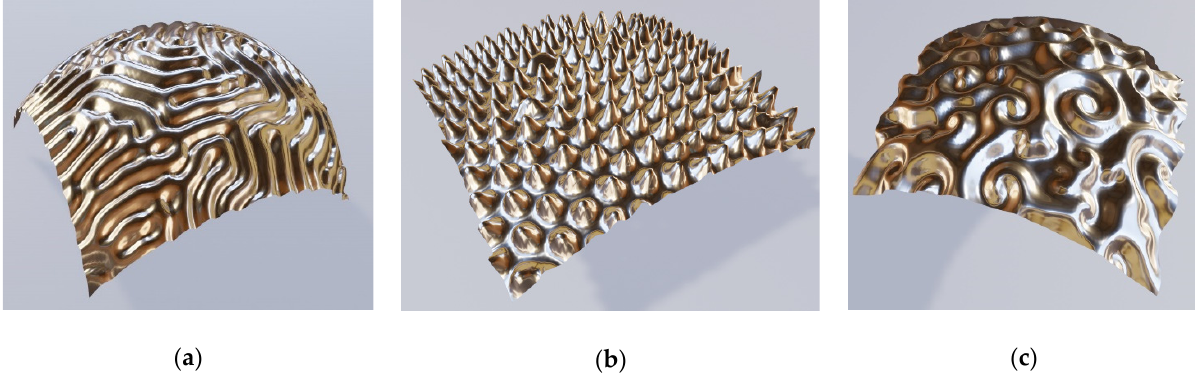
Figure 8. Calottes with templated reliefs corresponding to Turing patterns of diffusion; ( a ) diffusion reaction lines; ( b ) diffusion reaction dots; ( c ) complex Turing diffusion reaction pattern.